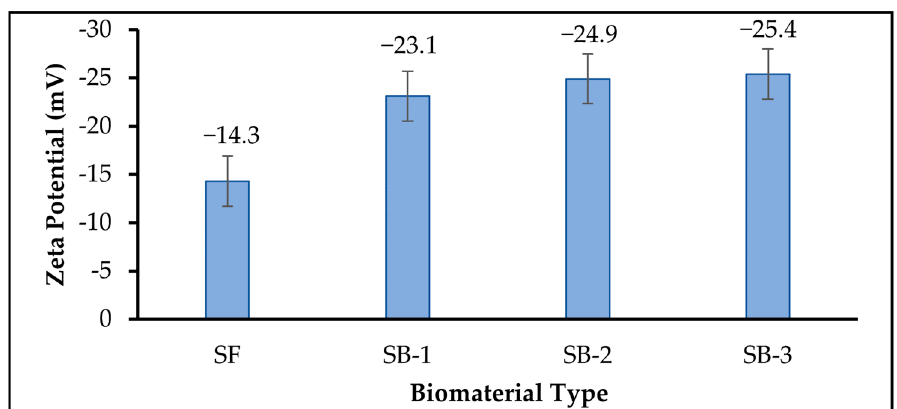
Figure 5. Zeta potential of sesame stalk feedstock (SF) and its different biochar types: SB-1 (formed around the inner sidewalls of the internal chamber), SB-2, (formed on the upper part of the internal chamber), and SB-3 (conventional production).